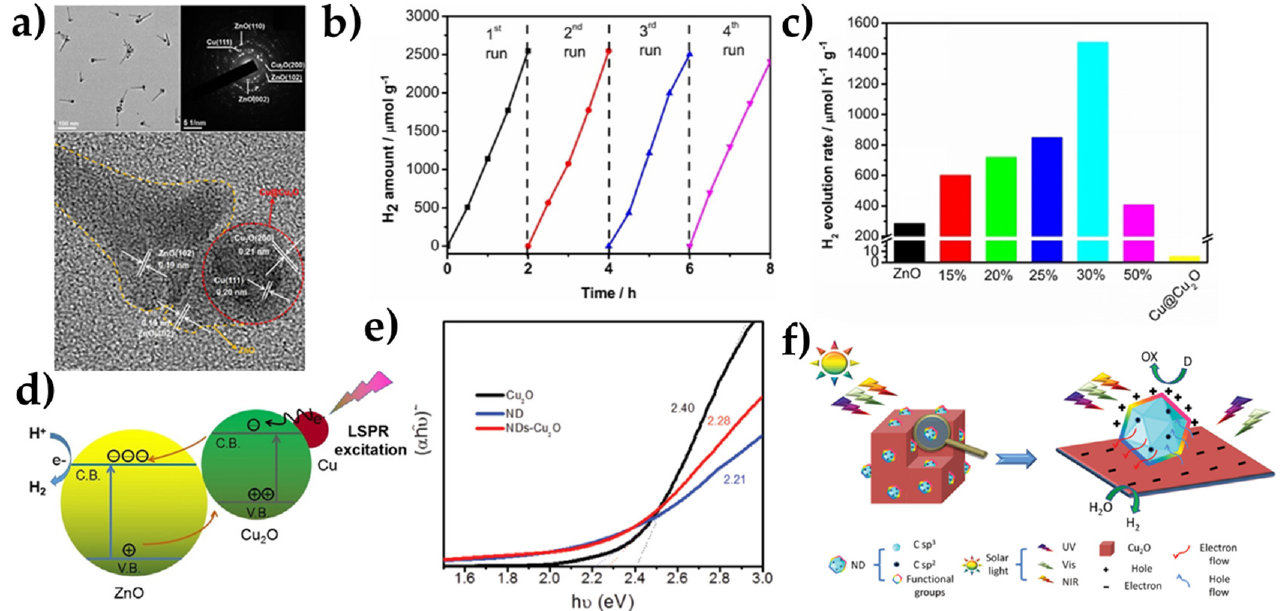
Figure 9. ( a ) TEM − SAED − HRTEM images of the Cu@Cu 2 O/ZnO nanocomposite; ( b ) Photocatalytic stability experiments of the Cu@Cu 2 O/ZnO (30wt%) where after four catalytic runs there was no significant decrease of the performance; ( c ) H 2 production rates of Cu@Cu 2 O/ZnO catalysts where 30% copper loading shows the best photocatalytic performance; ( d ) Proposed photocatalytic H 2 production mechanism of the Cu@Cu 2 O/ZnO under visible light irradiation. Reproduced with permission from ref. [62], Copyright 2018 Wiley − VCH; ( e ) Tauc plots of Cu 2 O, ND and NDs − Cu 2 O where the addition of NDs decreases the energy gap of Cu 2 O. ( f ) Schematic representation of the photocatalytic mechanism of NDs − Cu 2 O; Reproduced with permission from ref. [65], Copyright 2015 Wiley − VCH.